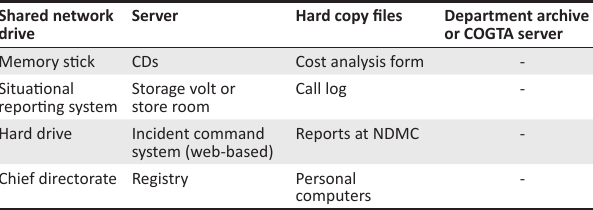
TABLE 2: Data storage methods.